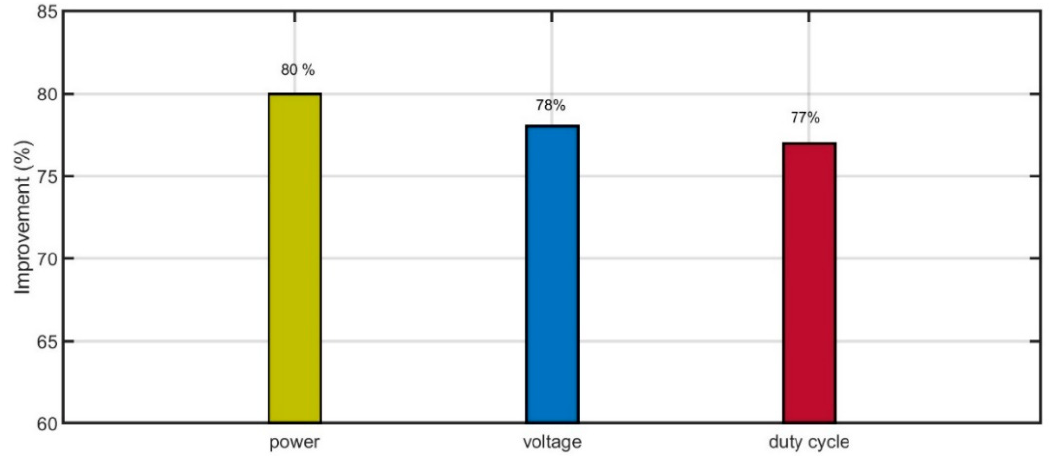
Figure 22. The comparison between the IC method and the cuckoo search method.